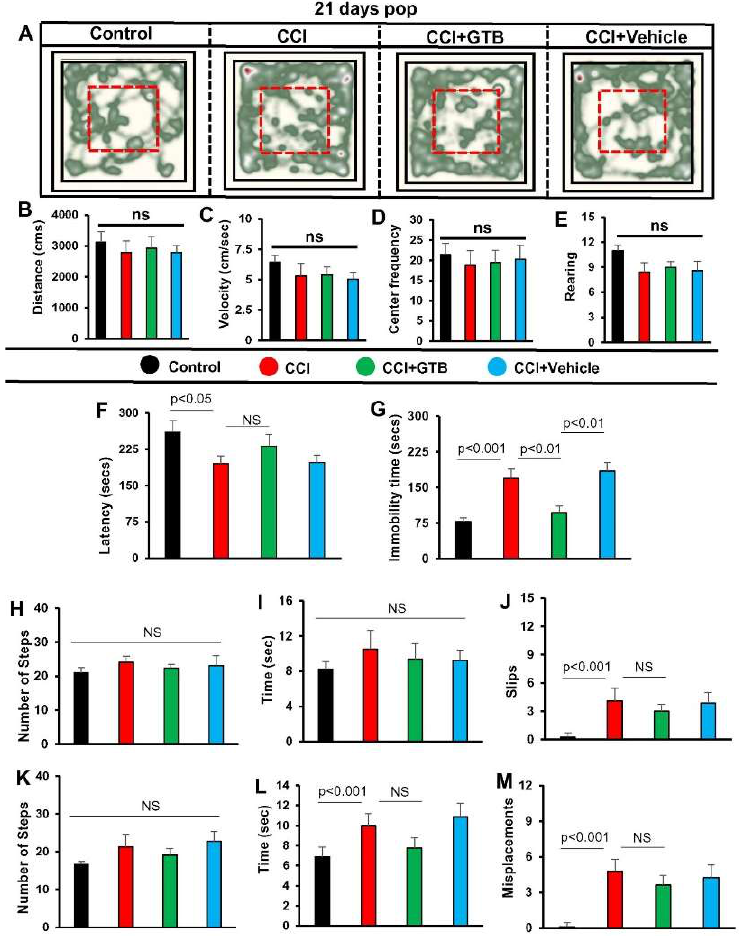
Figure 7. Effect of GTB on motor functions in TBI mice on the 21st day of CCI injury. TBI was induced in mice by CCI injury and after 24 h of injury, mice were treated with 50 mg/kg/day of GTB via oral gavage. Twenty-one days after CCI injury, mice were tested for open field behavior (( A ), heat map analysis monitored by using the Noldus system; ( B ), distance moved; ( C ), velocity; ( D ), center frequency; ( E ), rearing), rotorod (( F ), latency), tail suspension test (( G ), immobility time), beam walking (( H ), number of steps; ( I ), time taken; ( J ), slips), and grid runway (( K ), number of steps; ( L ), time taken; ( M ), misplacements). Six mice were used in each group. Statistical analyses were performed by one-way ANOVA followed by Tukey’s post hoc